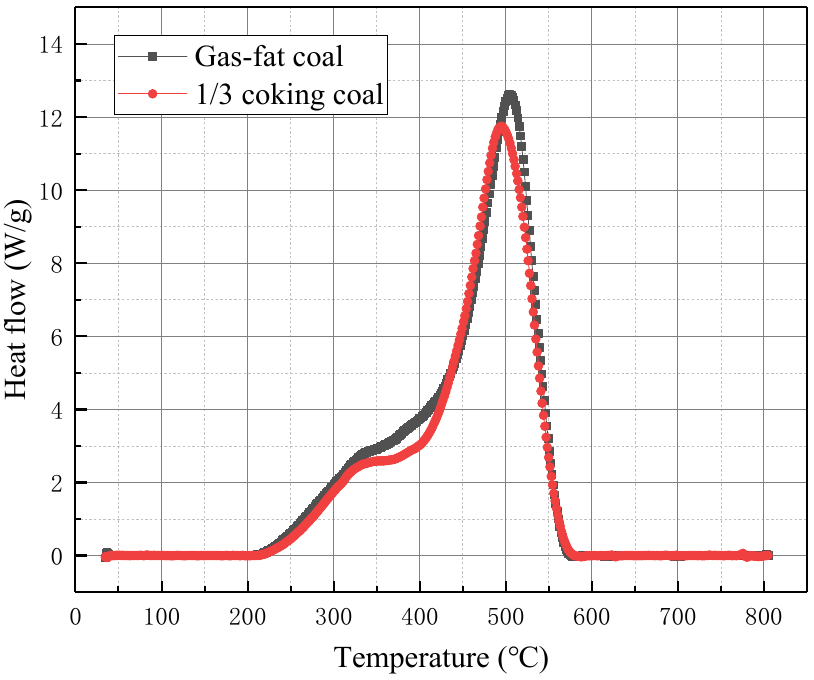
Figure 3. DSC curves of temperature versus heat flow at a heating rate of 5 °C/min. Exothermic reaction occurred in the process of spontaneous coal combustion. The heat flow increased with the temperature rose. When the temperature reached a certain point where the fire occurred, the heat flow began to lessen. Gas-fat coal produced the amount of heat of 16.68 J/g from 230 to 560 ◦ C, and 1/3 of coking coal generated 15.63 J/g from 270 to 560 ◦ C. The heat flow of gas-fat coal was higher than that of 1/3 of coking coal.